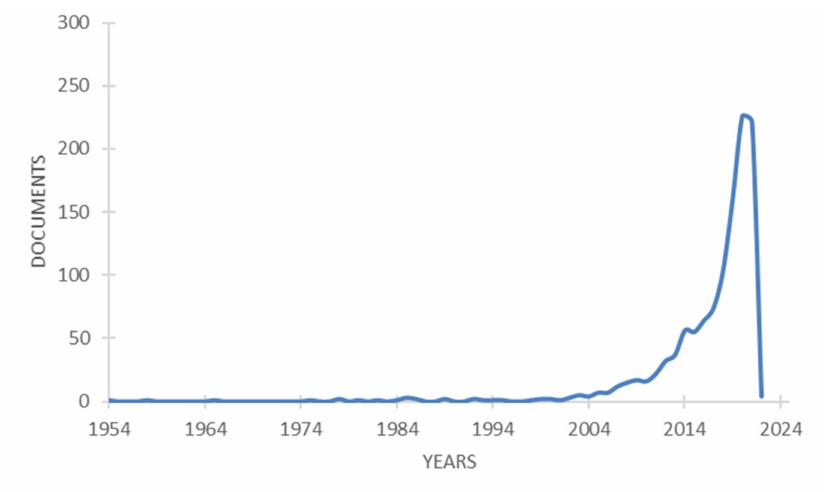
Figure 1. Publication trends for fruit wastes/by-products research are displayed as cumulative functions (Bibliometric data were extracted from the Scopus online